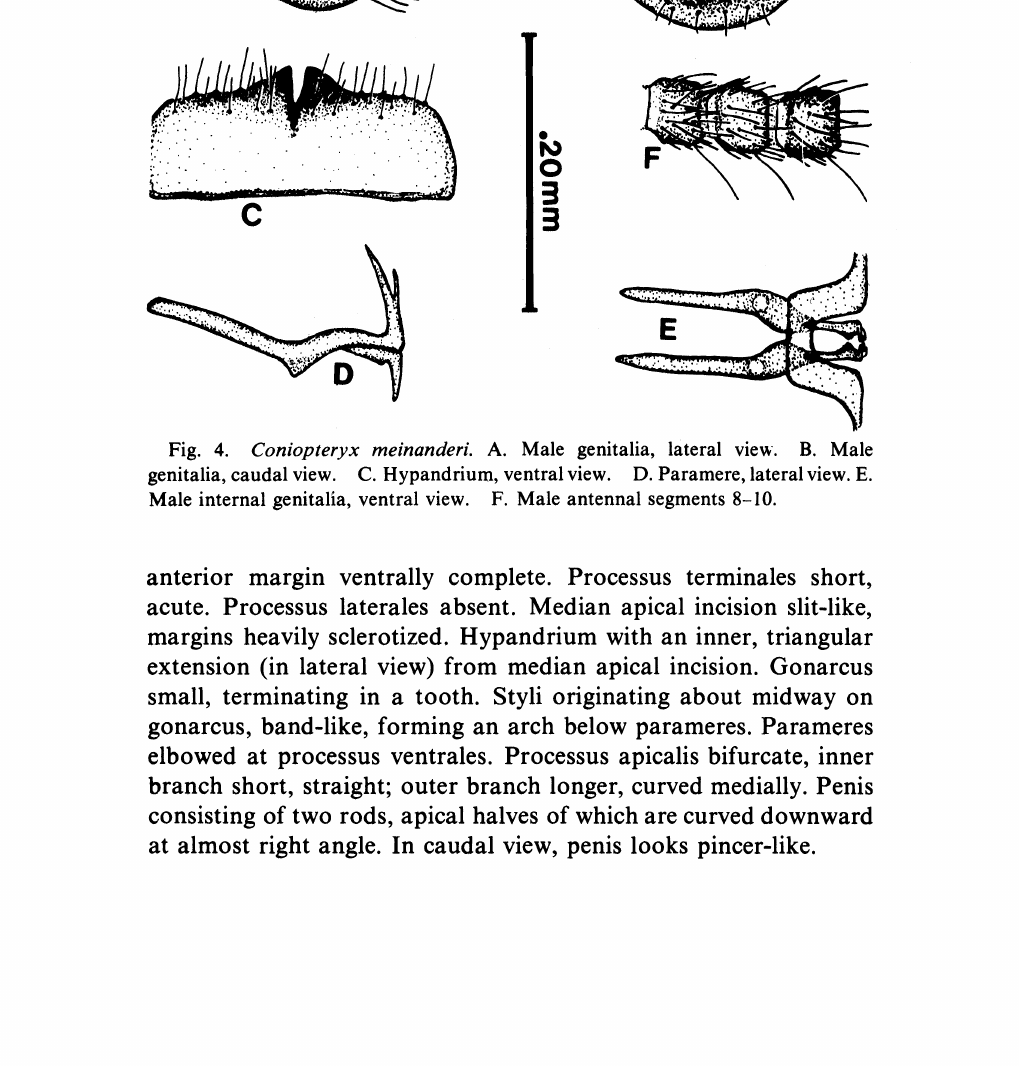
Fig. 4. Coniopteryx meinanderi. A. Male genitalia, lateral view. B. Male genitalia, caudal view. C. Hypandrium, ventral view. D. Paramere, lateral view. E. Male internal genitalia, ventral view. F. Male antennal segments 8-10.